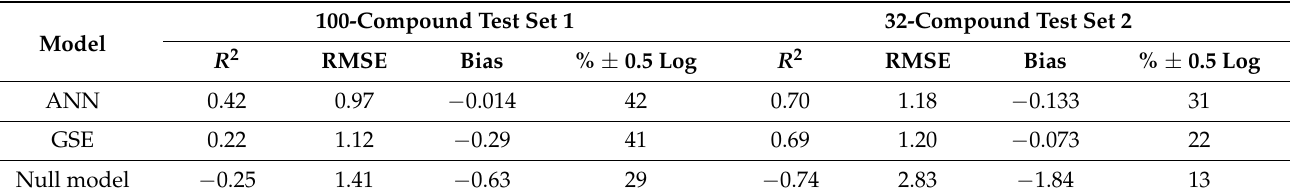
Table 4. Statistical measures of prediction performances obtained for the SC-2 test datasets.